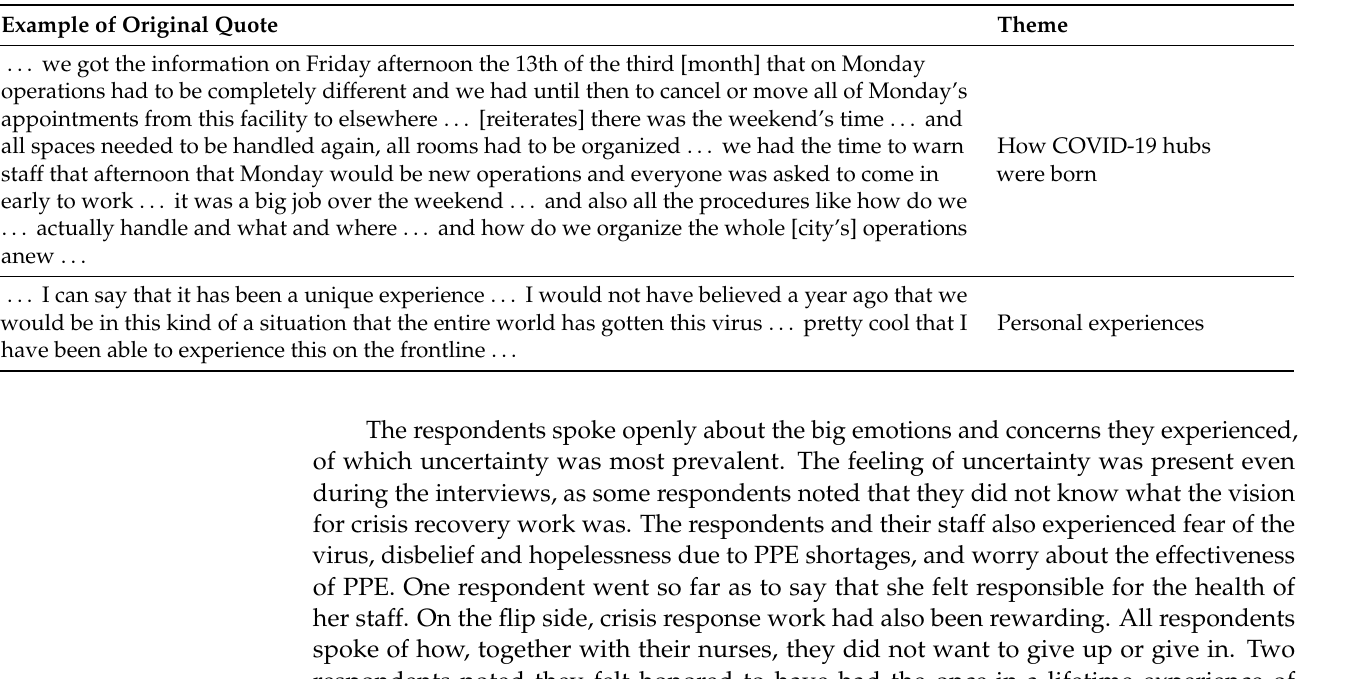
Table 5. Example quotes depicting respondents’ personal